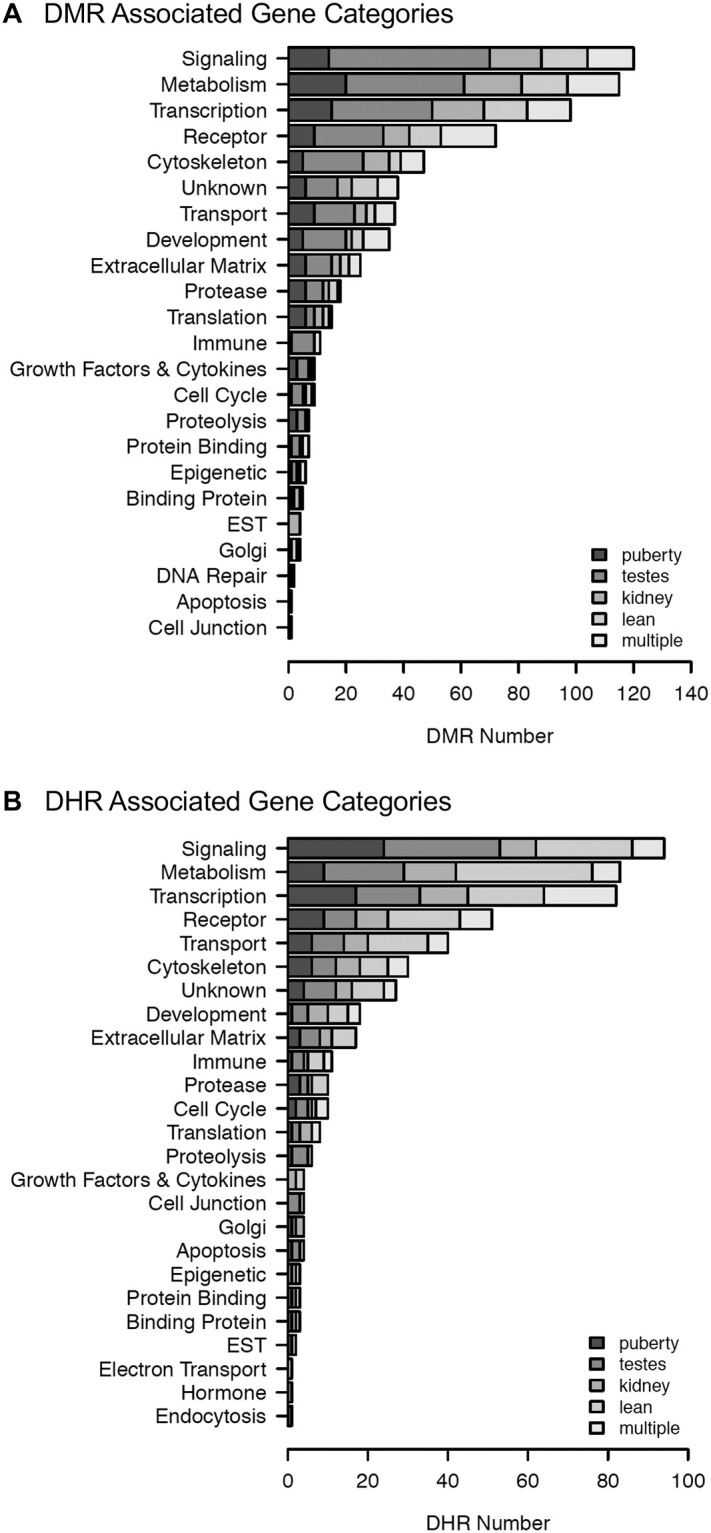
Associated gene categories.(A) DMR associated gene categories. (B) DHR associated gene categories. The gene categories and number of associated genes are presented for each disease group.